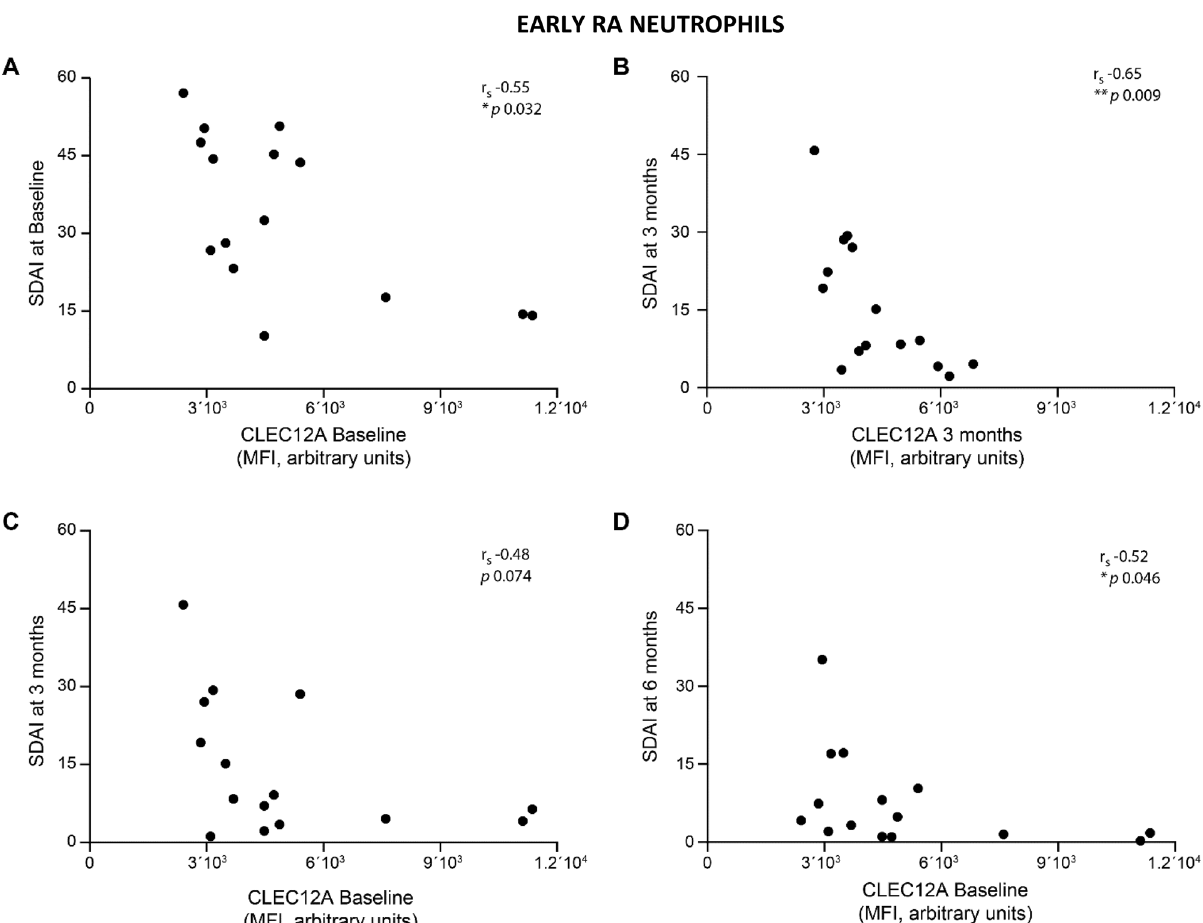
Figure 1. Neutrophil CLEC12A expression in eRA patients correlates with SDAI. Cell-surface, CLEC12A expression was determined by flow cytometry on circulating neutrophils of eRA patients. Cross-sectional correlations between neutrophil CLEC12A expression and SDAI score in eRA patients at (A) baseline, and (B) three months. Correlations between baseline, neutrophil CLEC12A expression and SDAI at (C) three and (D) six months. Statistical analysis: Spearman’s rank correlation coefficient and p value are shown in each panel. Symbols represent individual